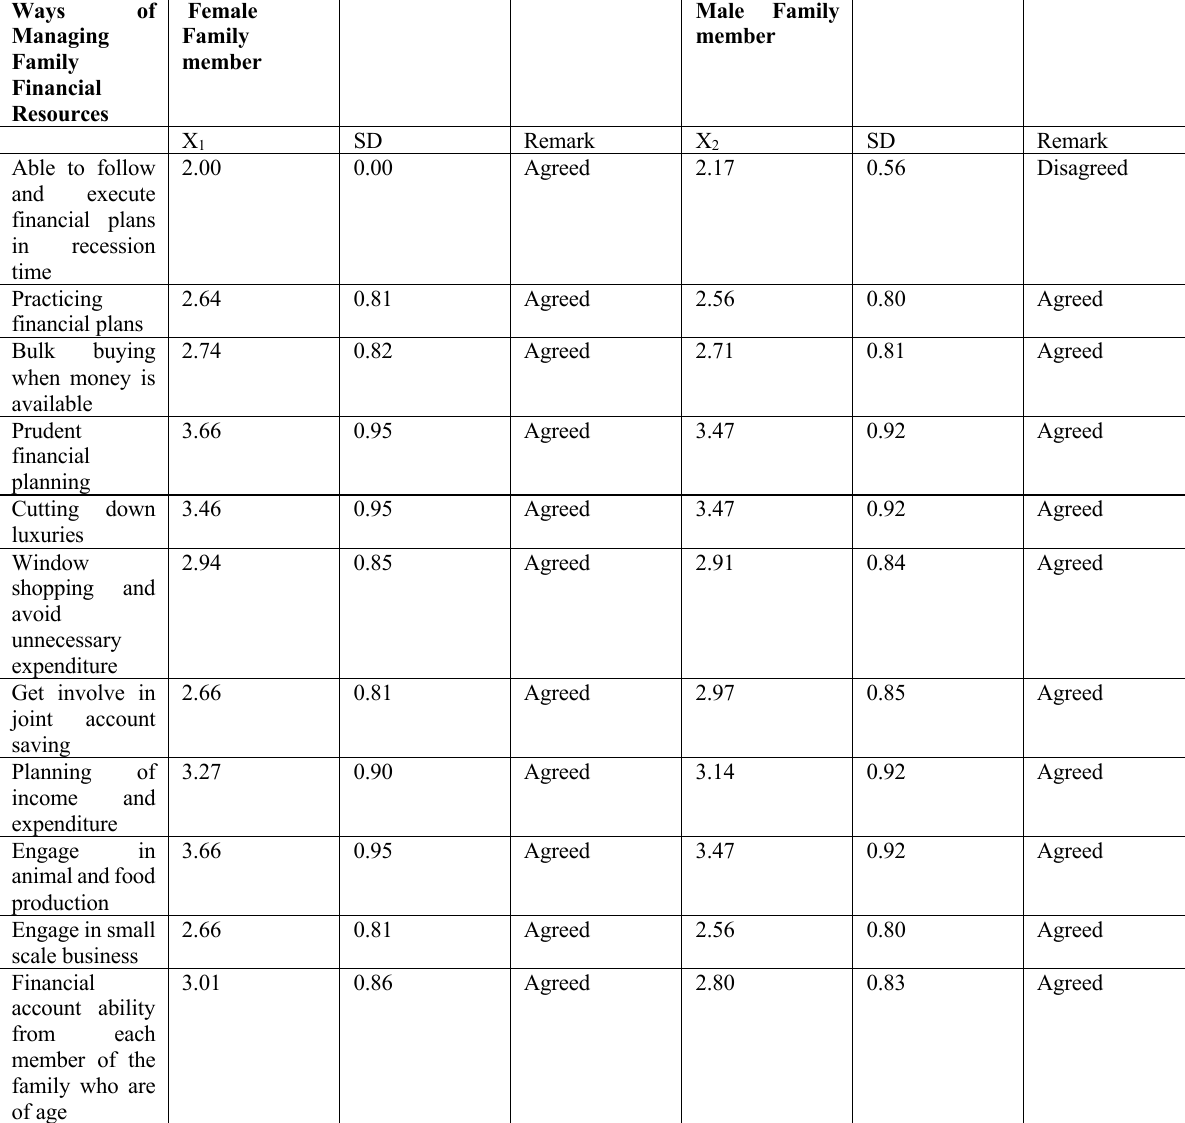
Table 2: Mean Responses on Ways of Managing Family Financial Resources in Economic